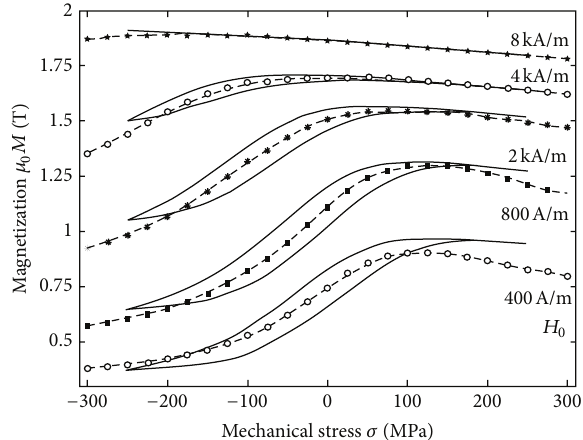
Figure 15: Experimentally obtained magnetomechanical hysteresis loop 𝑀(𝜎(𝑡)) for different setting of external DC magnetic field 𝐻 0 (full lines) and compared to the reversible anhysteretic magnetome- chanical behaviour at corresponding setting of 𝐻 0 (dashed line with symbols). Material: low carbon steel with 0,12% C [76].